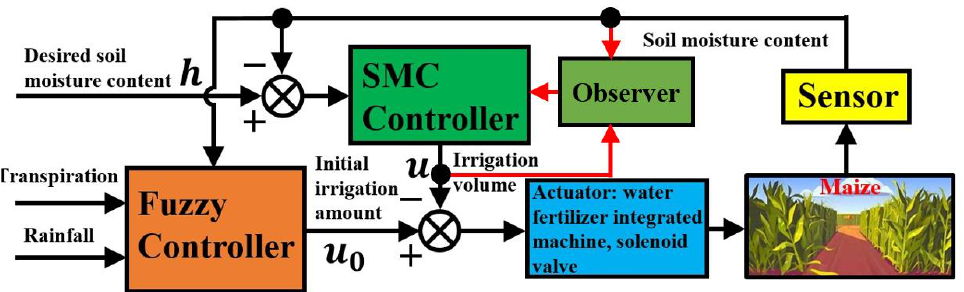
Figure 3. Structure of the fuzzy sliding mode control system.